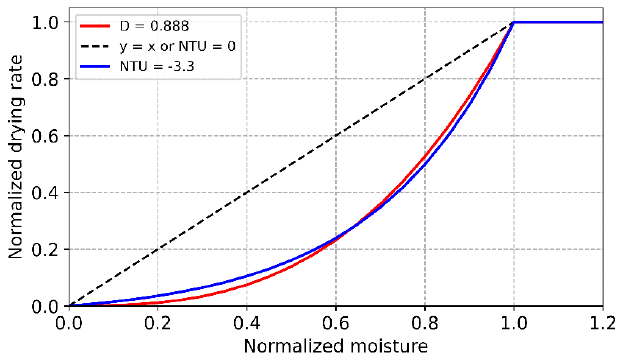
Figure 10. Drying curve based on polynomial and NTU equations.